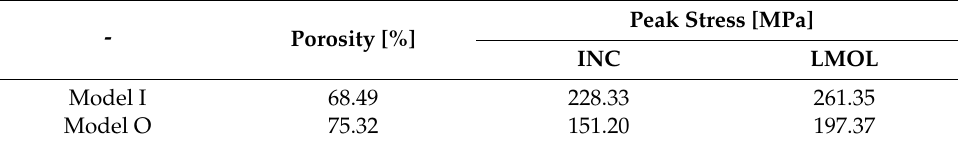
Figure 8. Geometric features ( A ) and strut diameter distribution ( B ) of the porous prostheses. Table 2 exhibits the porosity and maximum stress distribution of the prosthesis. The maximum stress of the initial prosthesis was 228.33 MPa and 261.35 MPa subjected to INC and LMOL loading, respectively. The maximum stress of the optimized gradient prosthesis was less than the target stress (200 MPa) and displayed increased porosity, thus, achieving the required efficacy. Table 2. The performance parameters for prosthesis, covering porosity and peak stress under two clenching loadings.